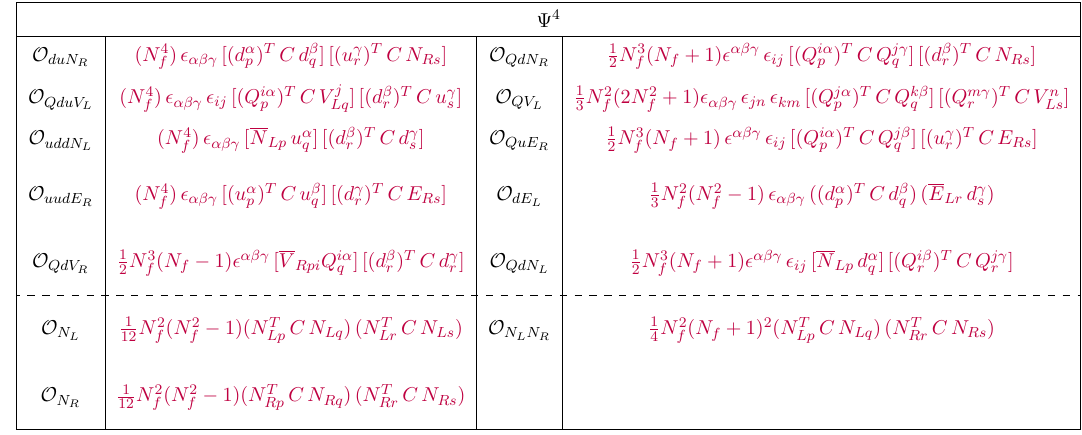
Table 15 . SM extended by Vector-like Leptons ( V L,R , E L,R , N L,R ): additional operators of dimen- sion 6. i, j, m, n and α, β, γ are the SU(2) and SU(3) indices respectively. p, q, r, s = 1 , 2 , · · · , N f are the flavour indices. The operators above the dashed line violate the baryon and lepton number (∆ B = 1 , ∆ L = ± 1) and below the dashed line violate only the lepton number (∆ B = 0 , ∆ L = − 4) . Ψ 4 O (1) QdLN L